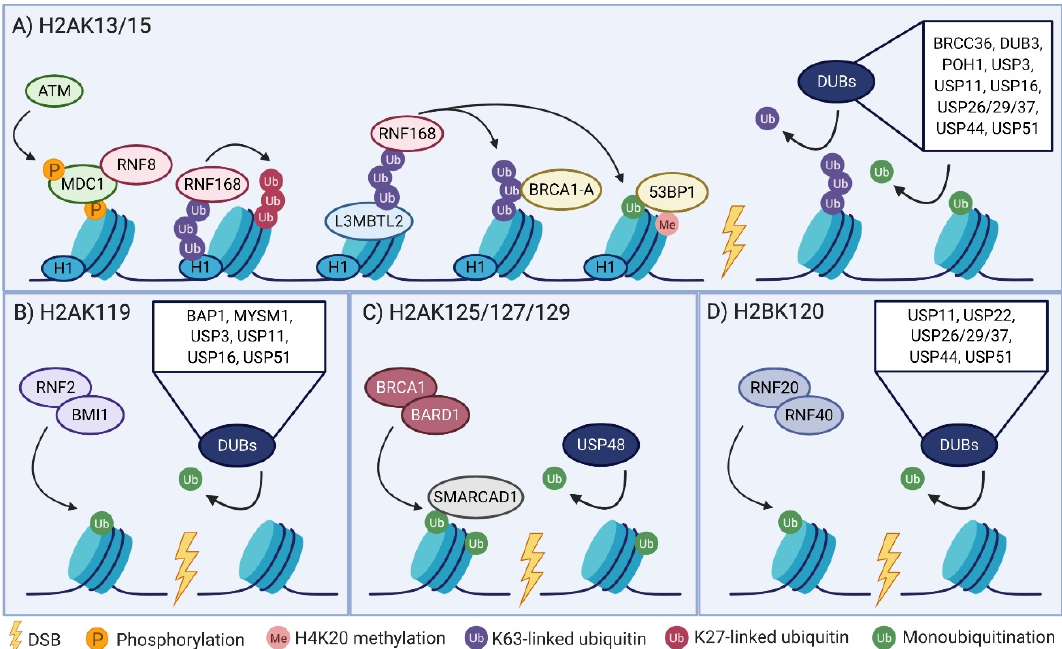
Figure 1. Mediators of ubiquitination and deubiquitination following a double strand break (DSB). ( A ) DSB induction, represented by a lightning bolt, leads to phosphorylation of H2AX ( γ H2AX) by ataxia-telangiectasia mutated (ATM) kinase. γ H2AX recruits MDC1, which in turn recruits RNF8. RNF8-mediated ubiquitination of H1 or L3MBTL2 has been proposed to recruit RNF168. The concerted actions of RNF8 and RNF168 result in the mono (green), K63-linked (purple), and K27-linked (dark pink) ubiquitination of lysines 13 and 15 on H2A-type histones. H2AK13 / 15 ubiquitination acts as a recruitment platform for downstream mediators of the DSB response including the BRCA1-A complex and 53BP1, the latter dually recognizing ubiquitin and H4K20 methylation (light pink). Deubiquitinating enzyme (DUB) activity towards H2AK13 / 15 influences the recruitment of these factors and ultimately impacts the efficiency of DSB repair. ( B ) A PRC1 catalytic heterodimer, most notably RNF2 and BMI1, catalyzes H2AK119 monoubiquitination. This mark facilitates transcriptional silencing and its removal by various DUBs can influence gene expression at sites surrounding DSBs. ( C ) Ubiquitination at H2AK125/127/129 is catalyzed by BRCA1-BARD1 in response to DSBs. This mark is subsequently recognized by SMARCAD1, which facilitates the repositioning of 53BP1 to promote DNA end resection and thus homologous recombination (HR). USP48 is currently the only identified DUB with specificity towards this residue. USP48 activity is most robust in the presence of auxiliary ubiquitin either at K119 or the BRCA1 site. While monoubiquitination is depicted in this figure, polyubiquitin chains may be synthesized at the BRCA1 site as well. ( D ) Monoubiquitination at H2BK120 is deposited by RNF20-RNF40. The reversal of this mark by several DUBs has been reported and may influence the accessibility of chromatin for downstream DSB mediators. While ubiquitination of H3 and H4 occurs, future studies warrant the investigation of these marks and the DUBs that reverse them in the context of DSB repair. Figure created with BioRender.com.